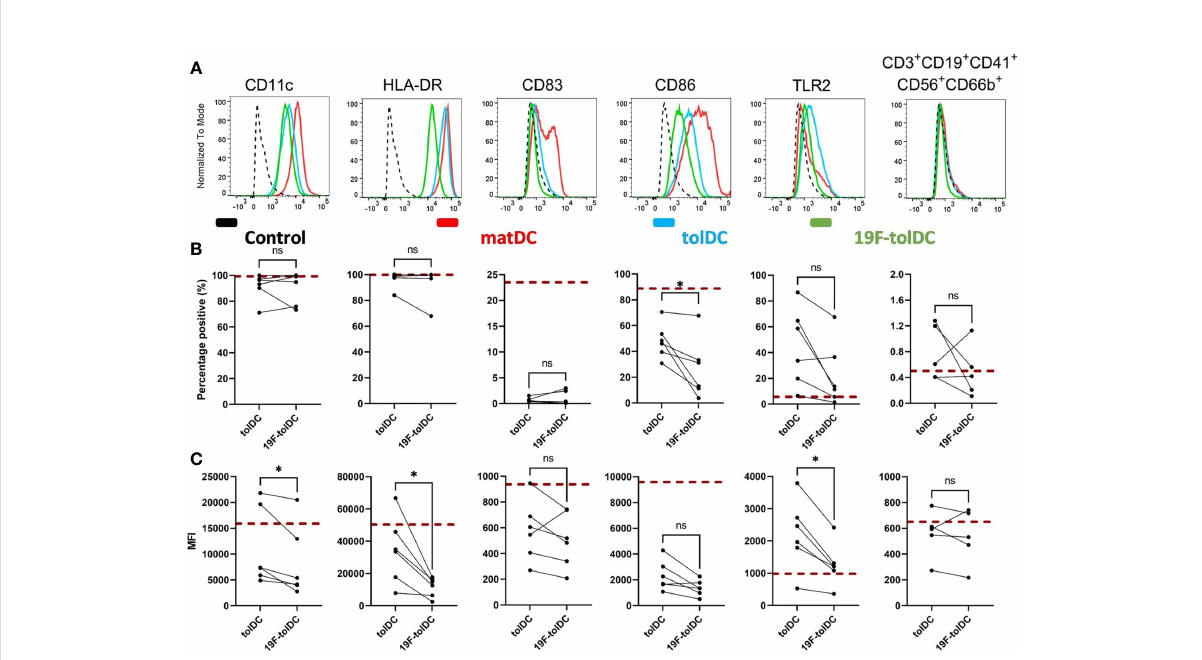
FIGURE 2 Cell surface marker expression of tolDC and 19 F-tolDC. 19 F-NP (2.2 mg/ml) was added to tolDC for the last 20-24 hours of culture, after which cells were harvested, washed and expression of tolDC QC markers was determined by fl ow cytometry. (A) Histograms (normalised to mode) of isotype-matched control (dashed line), mature DC (red line), tolDC (blue line) and 19 F-tolDC (green line). The graphs display expressing the QC surface markers by tolDC and 19 F-tolDC as percentages (B) and MFI (C) Red dashed line indicates median values of the matDC control. Graphs show 6 repeats, connecting line indicates paired samples (*p ≤ 0.05). NS, not signi fi